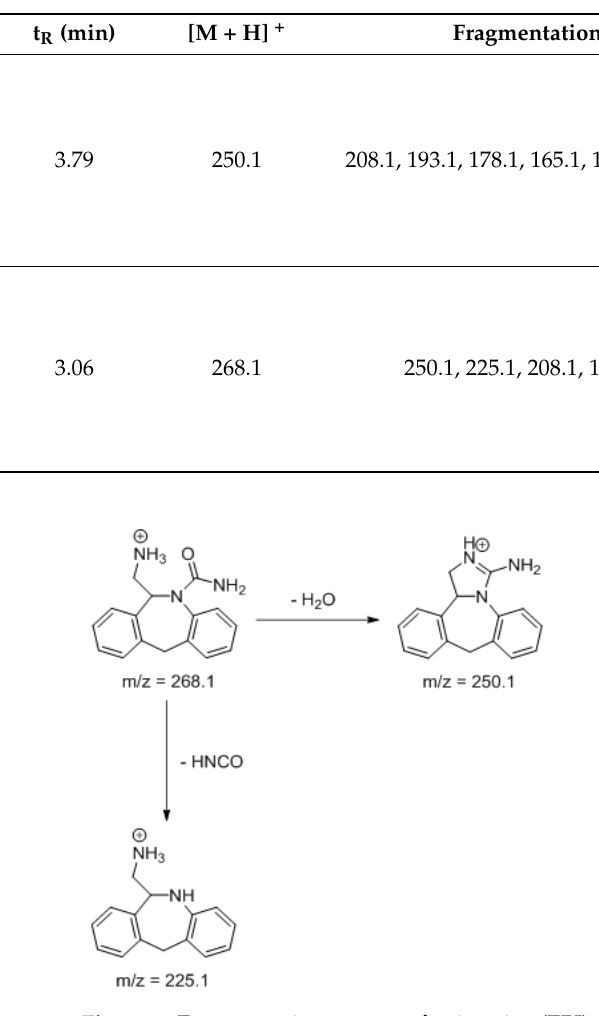
NH 2 Figure 10. Proposed degradation pathway of epinastine (EPI) in alkaline conditions at 70 °C. As far as EME was concerned, its degradation at different pH and high temperature followed the pseudo-first-order kinetics, too (Figure 3). The drug was shown to be easily degraded and similarly sensitive to low and high pH values, with all rate constants at the level of 10 − 3 min − 1 . The calculated t 0.5 values were 3.58 h and 4.57 h (0.1 M HCl and buffer of pH 3.0), 2.95 h (pH 7.0 and 10.0) and 2.08 h (0.1 M NaOH) (Table 2). At the same time, EME was shown to be much more sensitive to high temperature than to U V/V IS irradia- tion at similar pH conditions [18]. When UPLC-MS/MS analysis was performed, EME showed a protonated molecule, [M + H] + , at m/z 303.2, while its MS/MS showed the prod- uct ions at m/z 246.2, 232.1, 218.1, 200.1, 174.1, 146.1 and 134.1 (Table 5). However, no deg- radation product was detected in the samples stressed at high temperature. On the con- trary, two degradation products of EME were detected and identified after photodegra- dation, when either the ethoxy moiety or 1,4-diazepine ring in the EME molecule were affected [18]. A literature survey revealed one more study in which acidic degradation of EME was described. One degradation product was isolated using the TLC method and identified as a dimmer of 1-(2-ethoxyethyl)-2,3-dihydro-1 H -benzimidazole with the molar mass equal to 380 [15]. Table 5. MS/MS results for emedastine (EME).